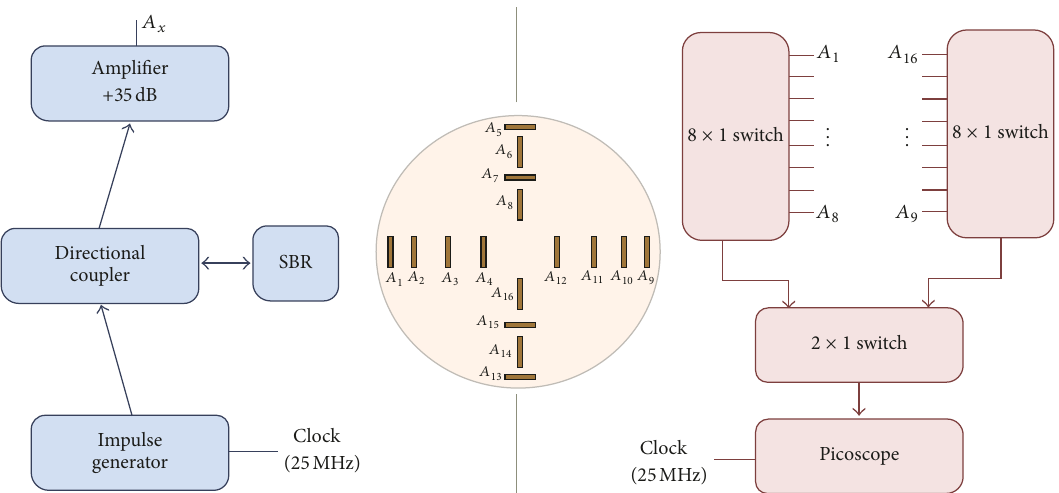
Figure 26: Schematic diagram of the time-domain breast imaging system of McGill University [29]. Image copyright IEEE, used with permission.